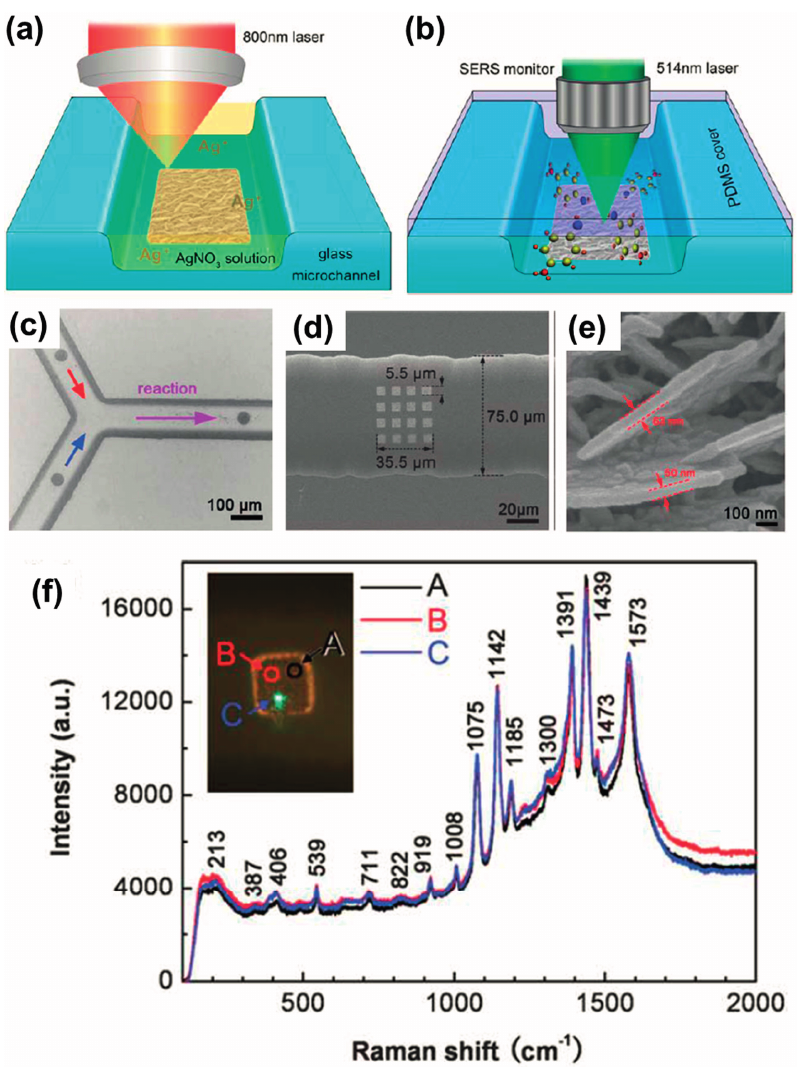
Figure 14. ( a ) Schematic illustration of fabrication process for silver SERS substrate inside a microfluidic channel; and ( b ) application for target molecule detection under visible light (514.5 nm) excitation; ( c – e ) SEM images of silver SERS substrates integrated into a microfluidic channel; ( f ) Raman spectra of p-aminothiophenol ( p -ATP) measured at the positions shown in the optical micrograph in the inset [137] (Reproduced with permission from RSC. © 2011 by the Royal Society of